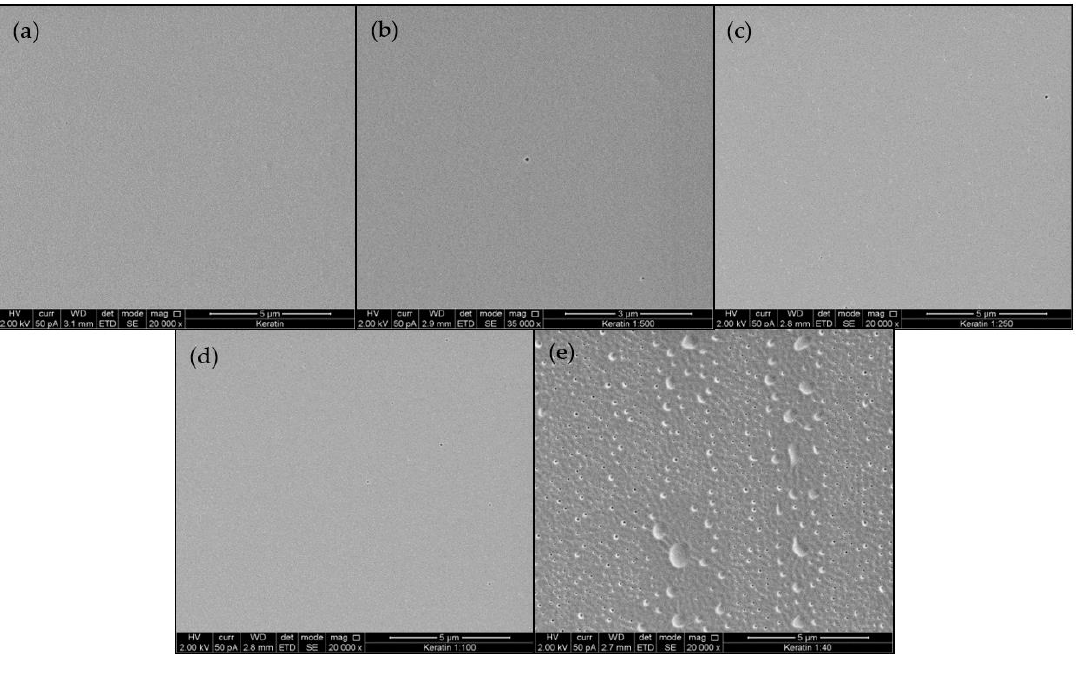
Figure 1. SEM imaging of the keratin / melanin films (KMFs) sequentially showing a smooth to perforated film surface as the ratio between keratin and melanin increases ( a – e ): KMF0, KMF500, KMF250, KMF100, and KMF40.